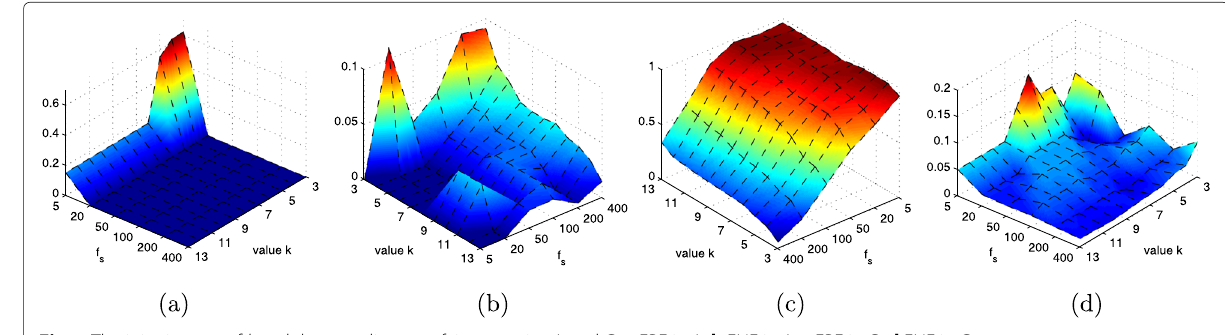
Fig. 7 The joint impact of k and the sampling rate f s in scenarios A and G. a FPE in A, b FNE in A, c FPE in G, d FNE in